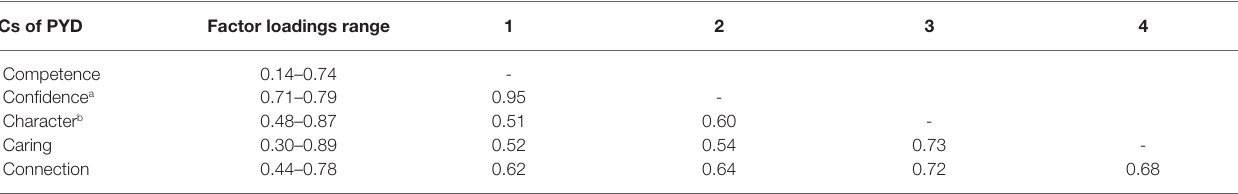
TABLE 3 | Summary of the confirmatory factor analysis for the best fitting model of the 5 Cs of Positive Youth Development – factor loadings and correlations. 5 Cs of PYD